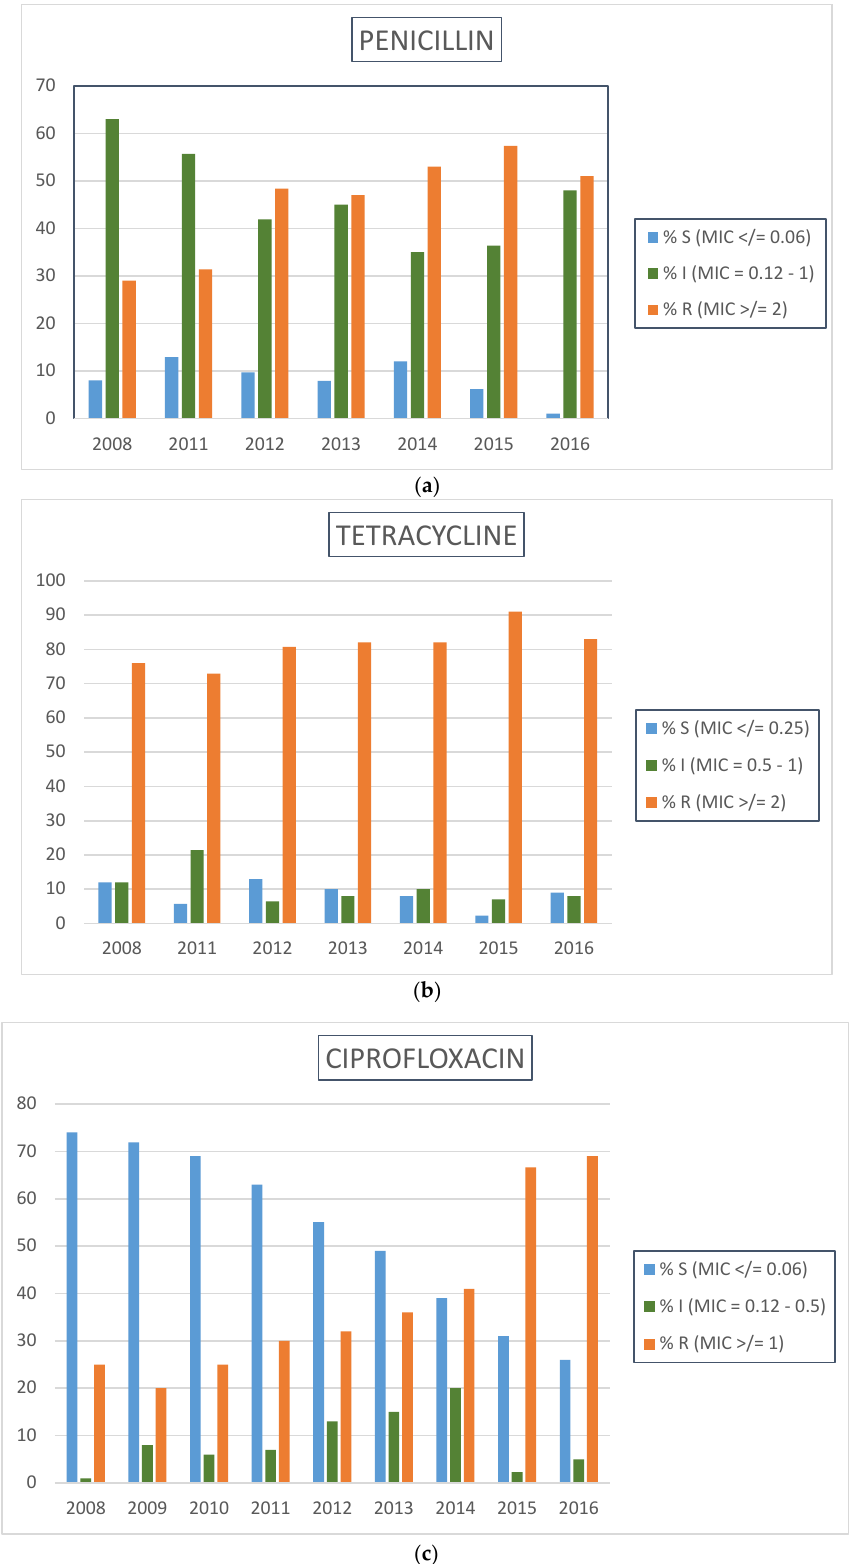
Figure 1. Prevalence of resistance by calendar year for ( a ) penicillin, ( b ) tetracycline, and ( c ) ciprofloxacin in Neisseria gonorrhoeae , Johannesburg, 2008–2016. Minimum inhibitory concentration (MIC) breakpoint criteria (µg/mL) as per Clinical Laboratory Standards Institute (CLSI) 2018; 28th Edition.